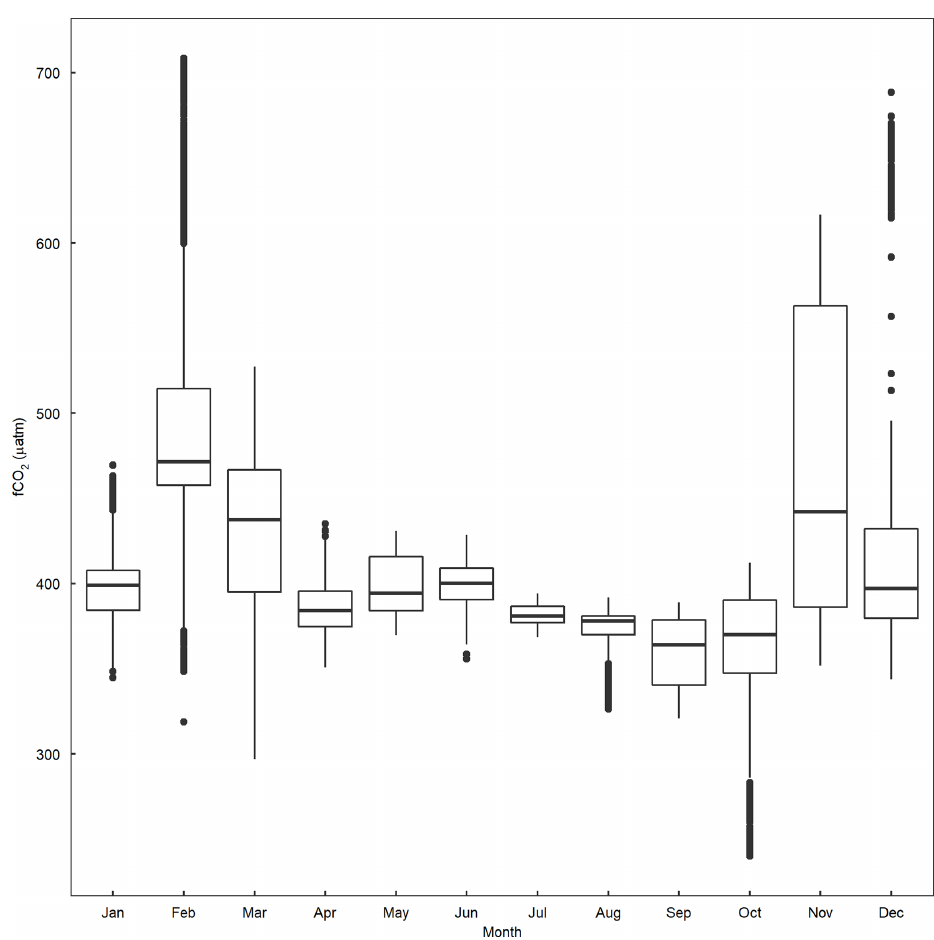
Figure A4. Boxplot depicting seasonal values of f CO 2 recorded between 1993–2019 at Storm Bay (43.1–42.8442 ◦ S, 147.307–147.46 ◦ E), Tasmania (Bakker et al.,